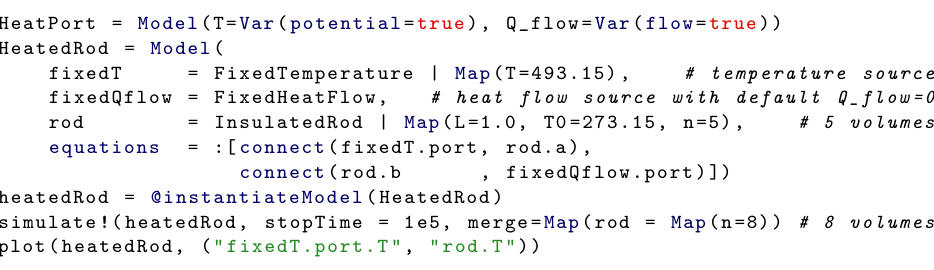
Figure A1. Space discretized partial differential equation of one-dimensional heat transfer in a rod with an isolated surface, defined with parameters L (length of rod), n (number of volumes), A (area), (cid:36) (density), c (specific heat capacity), λ (thermal conductivity), T 0 (initial value in every volume), states T i (temperatures in the middle of every volume), thermal connectors a , b with potential variables a T , b T (temperatures), and flow variables a Q , b Q (heat flow rates). flow flow Listing A6 . Simple usage of isolated rod InsulatedRod with one-dimensional heat-transfer that is connected on the left side with a fixed temperature source FixedHeatFlow with T = 220 ◦ C = 493.15 K, and on the right side with a fixed heat flow source FixedHeatFlow with Q flow = 0.